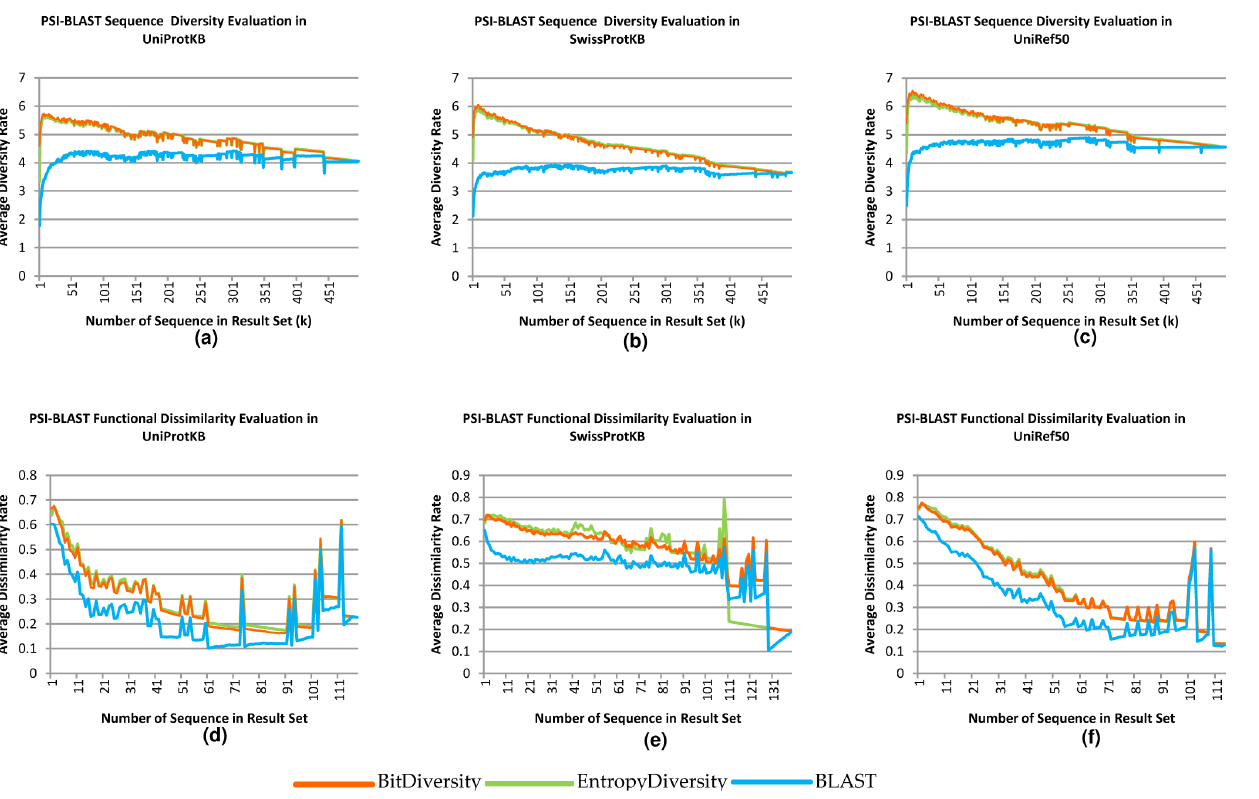
Fig. 6. Comparisons based on sequence diversity and functional dissimilarity measures in different databases: UniProtKB, SwissProtKB and UniRef50. The experiments are done by using random 1000 UniRef50 sequences on PSI-BLAST Web services. For a, b, and c, the x axes represent the average sequence diversity rate calculated with Rao’s entropy method and the y axes show the size of the diversified set(k). For d, e, and f, the x axes represent the average functional dissimilarity rate based on Wang et al.’s similarity on molecular function GO DAG. The y axis is the same as the a, b, and c.